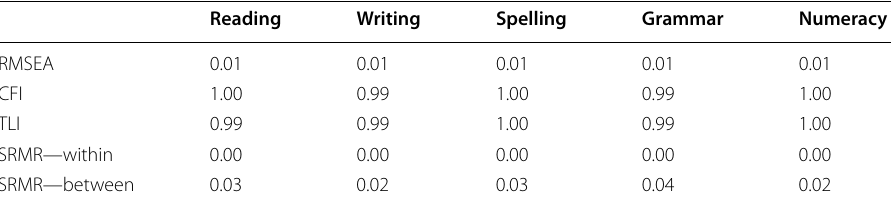
Table 5 Grade nine model fit indices